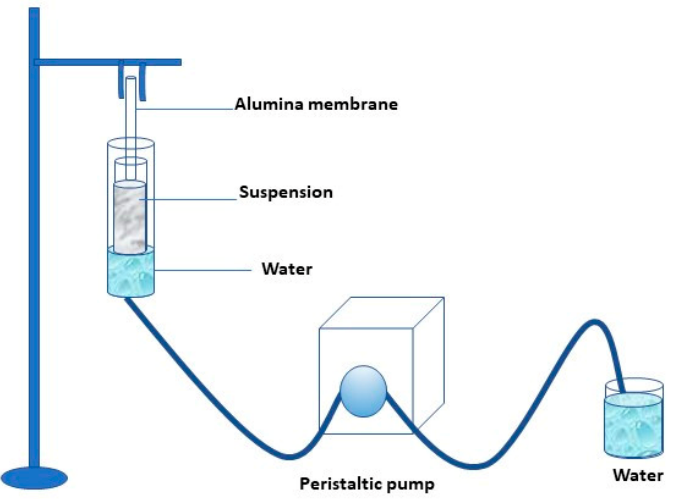
Figure 1. Scheme of the lab plant used for the preparation of the photocatalytic membrane.